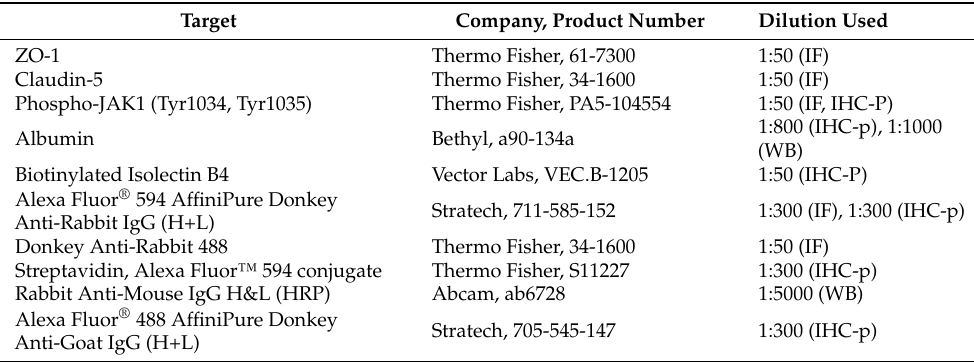
Table 1. Antibodies used for Immunostaining and Western